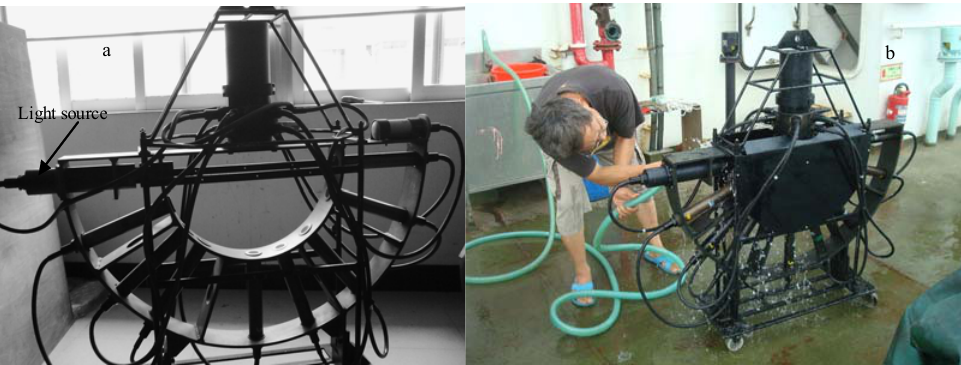
Figure 4. ( a ) Light source and receiver array of the VSF instrument; ( b ) The actual structure with two light-tight plates on each side of the semicircle.